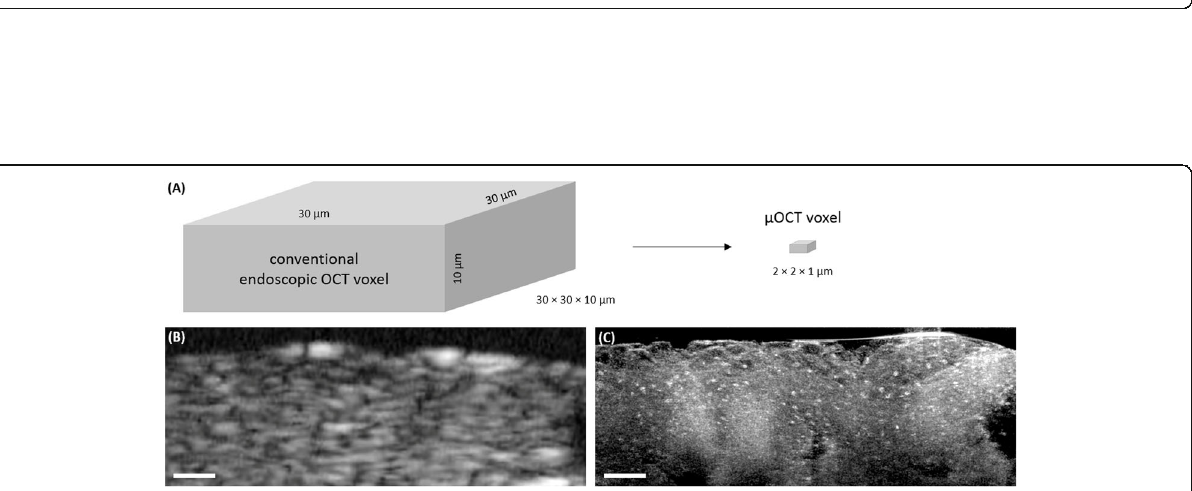
Fig. 5 Milestone 3: Cartoon illustration of the advantage of PS-OCT over conventional OCT using the example of subepithelial fibrosis of esophageal tissue (as in EoE). a and b depict histologic sections, c and d OCT intensity scans, and ( e ) and ( f ) OCT local phase retardation (a measure of birefringence) images of two pathologically different stages (healthy vs. fibrosis). While the OCT intensity scan of the fibrotic tissue region may not allow quantification of subepithelial collagen, the PS-OCT image clearly outlines the fibrotic area and even allows for quantitative birefringence evaluation. g and h depict swine esophagus images acquired by an endoscopic PS-OCT system ex vivo , showing the layered structures of epithelium and lamina propria/muscularis mucosa. Intensity ( g ) as well as accumulated phase retardation ( h ) are shown, respectively (figure and caption adapted and reprinted with permission from [83] © The Optical Society )